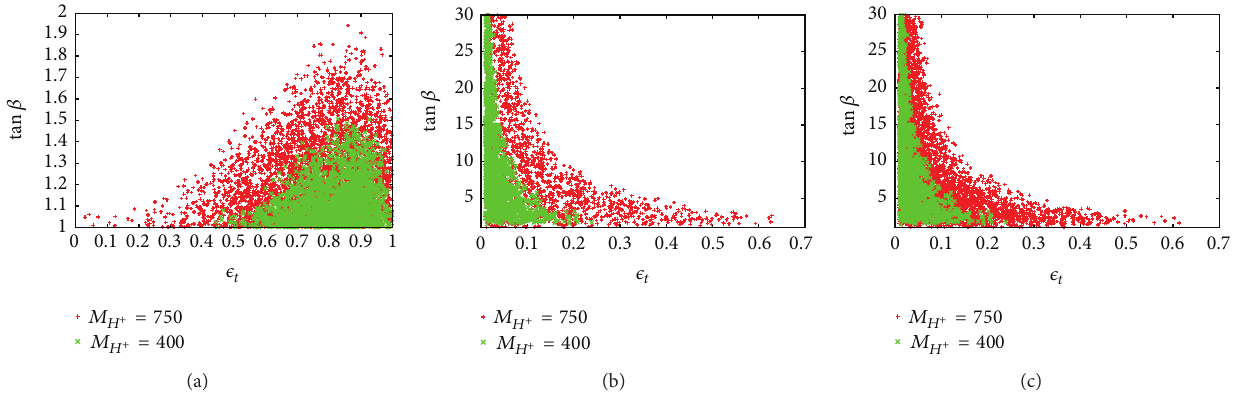
󸀠 | = 10 −5 ): the allowed parameter space in the tan 𝛽 − 𝜖 𝑠𝑏